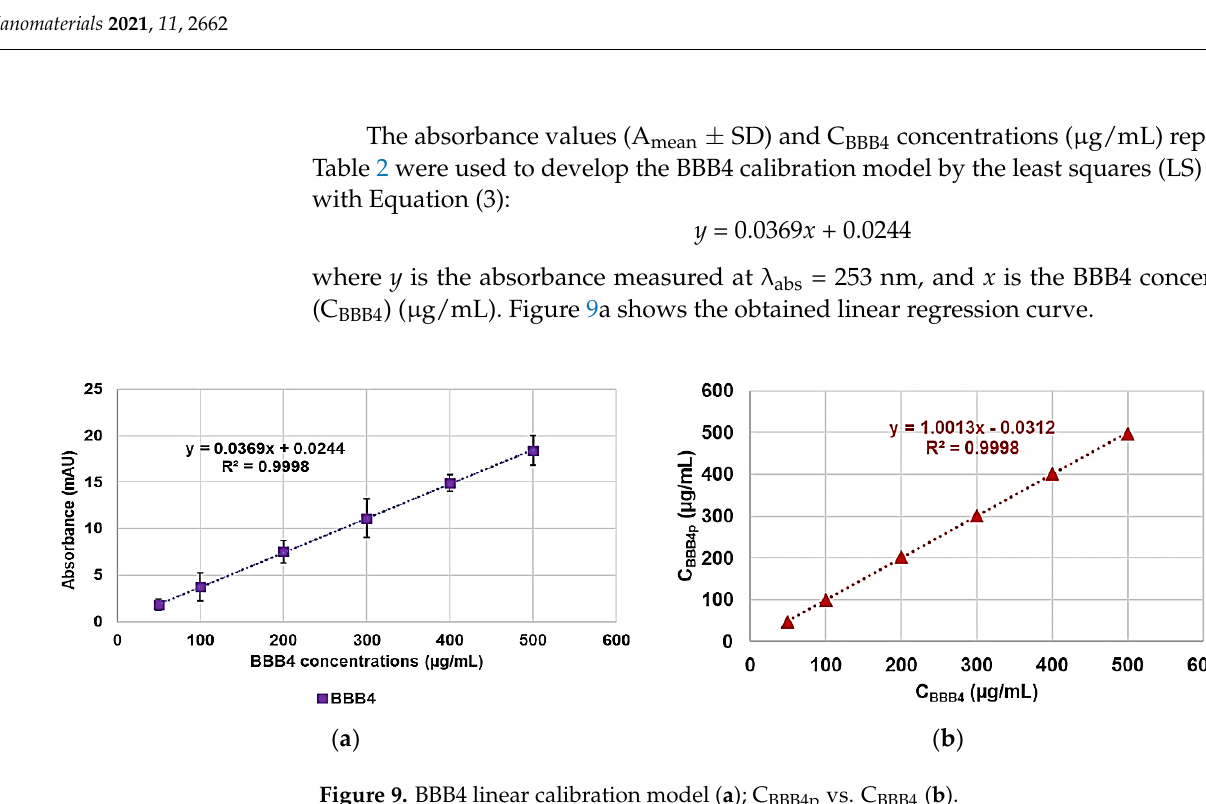
18 of 27 Table 2. Data of the calibration curve: absorbance (A mean ± SD), BBB4 standards concentrations (C BBB4 ), BBB4 predicted concentrations (C BBB4p ), residuals, and absolute percentage errors. C BBB4 (µg/mL)